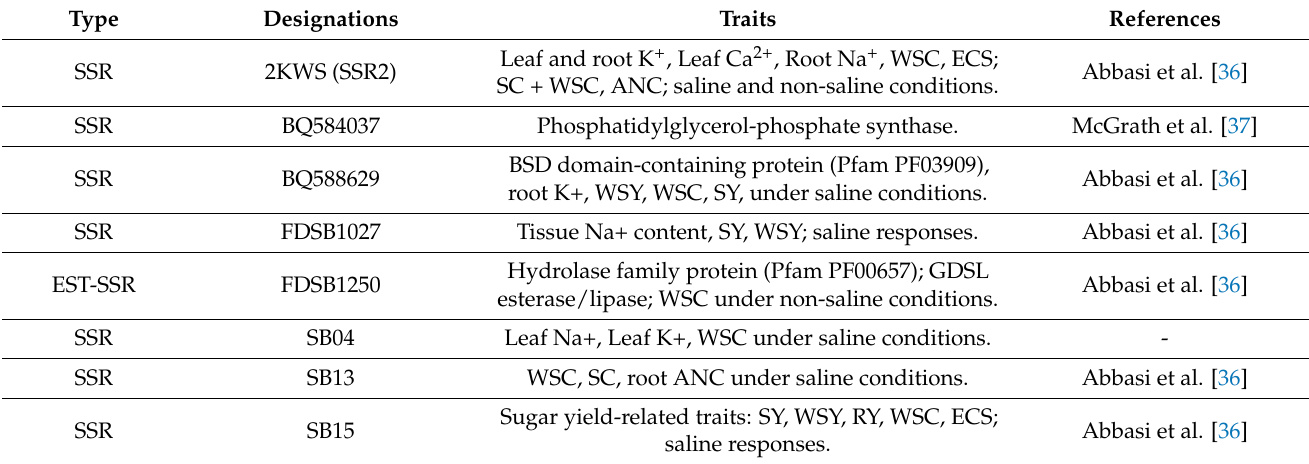
Table 1. SSR markers designations, associated traits and bibliographic